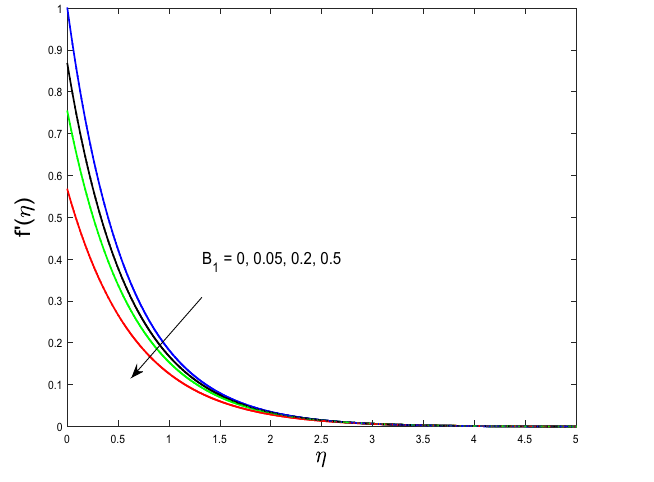
Figure 3. Plot of f ′ for B 1 .